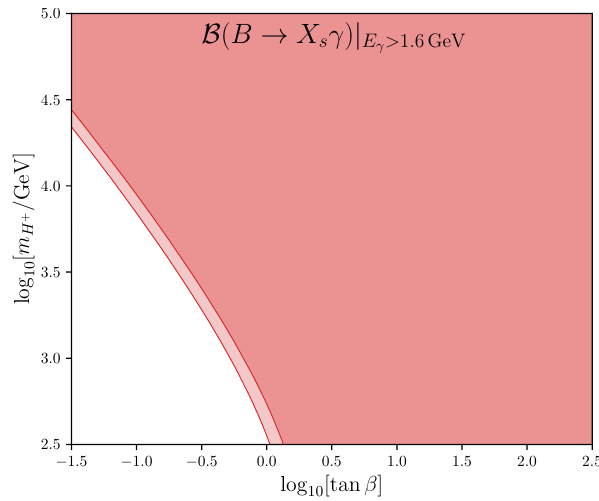
Figure 5 . Contour plot of the allowed 2HDM-I parameter space in the ( tan β − m B ( ¯ B → X s γ ) . The darker contour indicates allowed parameter space at 1 σ confidence, and the lighter at 2 σ